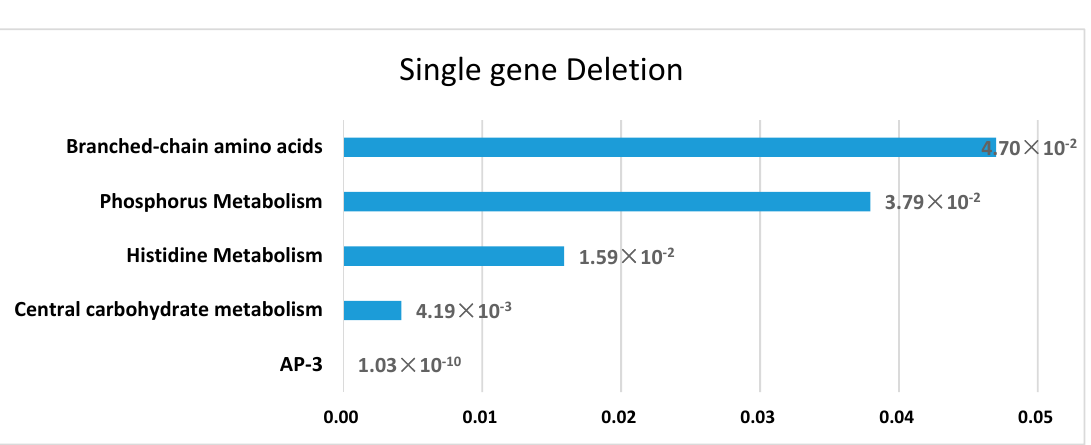
6 of 17 Figure 2. Percentage of reactions in each subsystem in Aspm1282 model. To validate the effectiveness of Aspm1282 in predicting AP-3 biosynthesis, essential gene analysis was performed by single-gene deletion, with the flux of AP-3 production as the objective function. There were 37 genes in the model predicted as influential genes, and 21 of them were found to be essential, whose deletions causing a decrease of AP-3 production more than 90% (Table S3 in